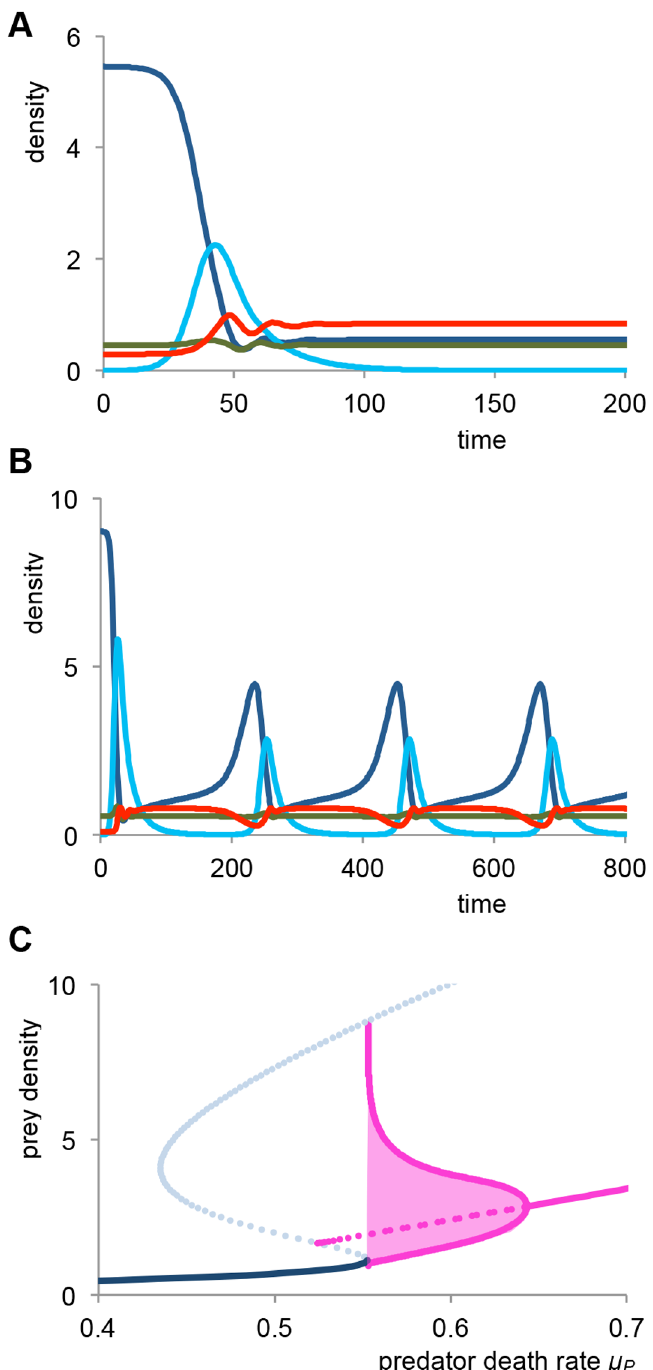
Fig 3. The disease can facilitate the predator, relieve stuntedness and induce recurrent epidemics. Parameters and colors are identical to Fig 2, except δ = 0, indicating that sick individuals do not effectively compete with healthy individuals. (a) Dynamics after introduction of the disease in the stunted population state for μ P . = 0.45. Here, the disease causes a single epidemic, after which the host population shifts to the non-stunted equilibrium and the disease goes extinct. (b) Dynamics after introduction of the disease in the stunted population state for μ P . = 0.56. After an initial large epidemic, the system settles in a limit cycle with recurrent epidemics of intermediate amplitude. Note that each epidemic is closely followed by an increase in predator density. (c) Bifurcation diagram for total juvenile prey density as a function of predator death rate μ P